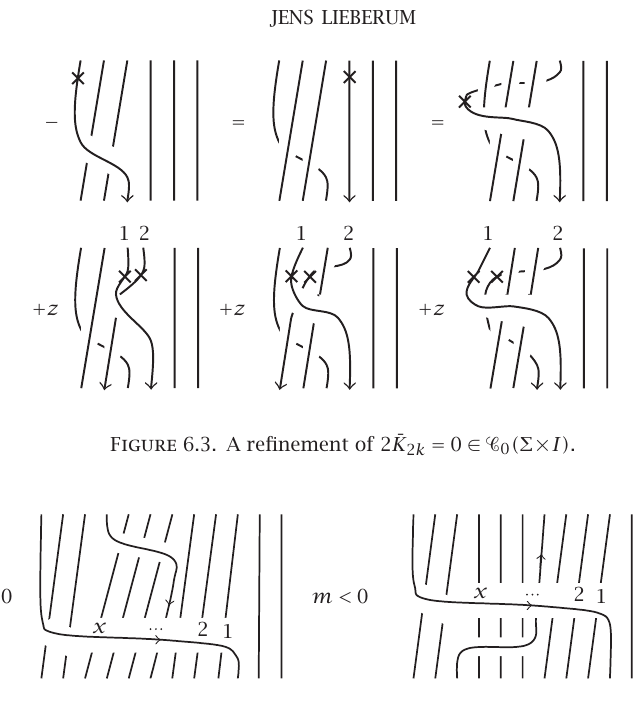
Figure 6.4 . The links K 5 K 7 and K 5 K − 7